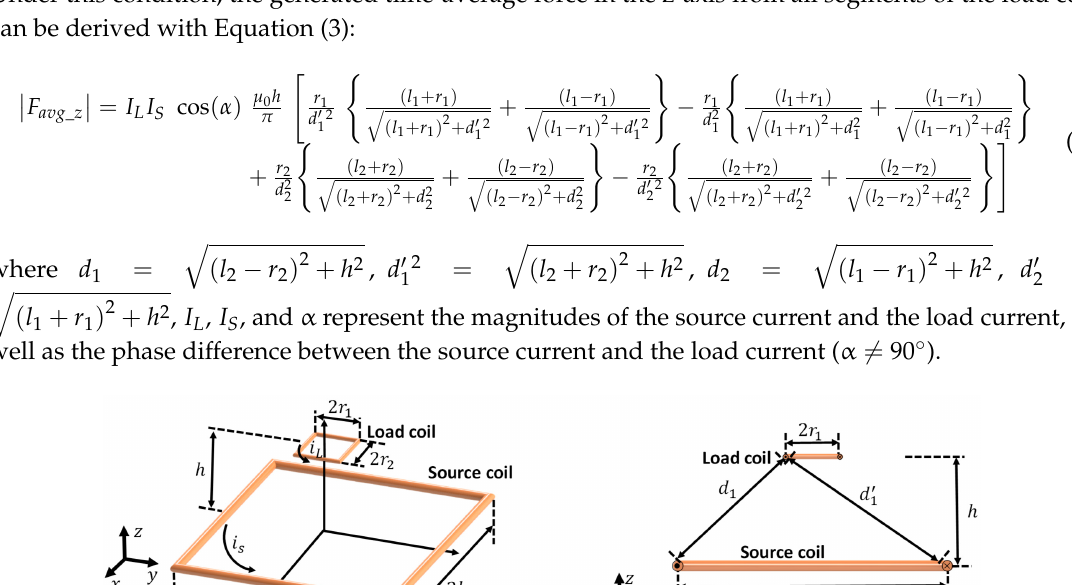
and for analytical calculation of force and 𝑙𝑙 1 , 𝑙𝑙 2 𝑟𝑟 1 , 𝑟𝑟 2